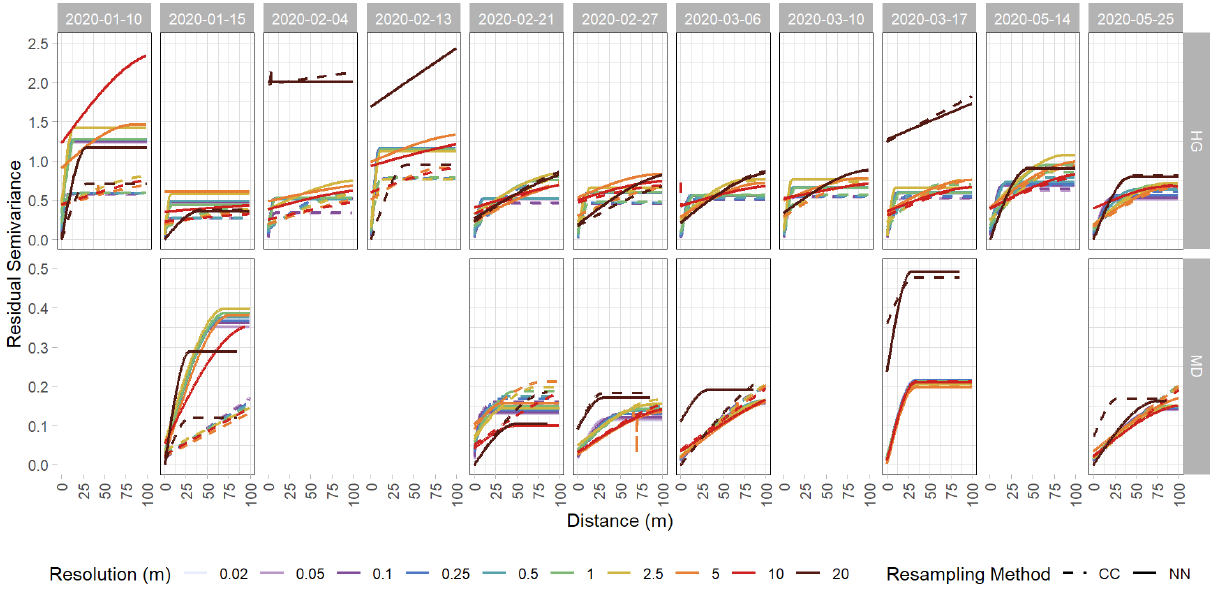
Figure A4. Spherically fit variograms of detrended snow depth residuals from the Hourglass (HG) and the meadow (MD). Each panel depicts a specific observation day, with solid lines representing nearest-neighbor (NN) resampling methods, dashed lines representing cubic- convolution (CC) resampling methods, and colors representing different snow depth DSM resolutions. Five observation days were removed from the meadow site time series due to poor model quality. Note different y axis scales for the HG and MD rows.